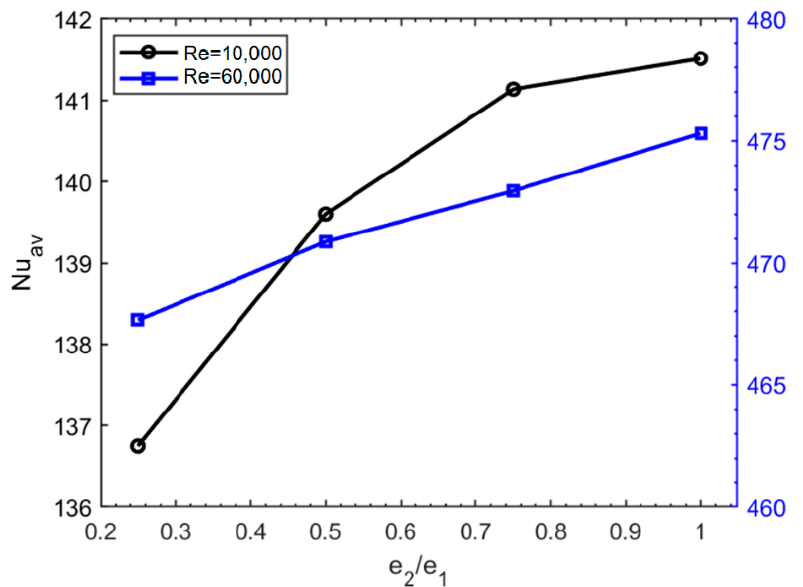
Figure 7. Change in the average Nusselt number (Nu av ) with the rib height ratio (e 2 /e 1 ) at two Re number values and a Pr number of 7.0.